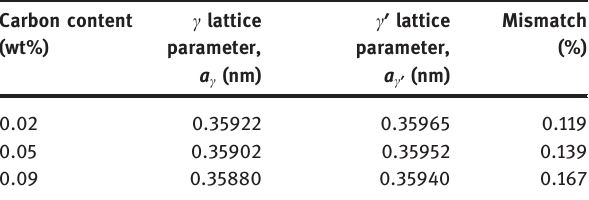
Figure 3: SEM micrograph showing carbides in Incoloy 901 alloys with (a) 0.05 wt% and (b) 0.09 wt% carbon with corresponding SEM-EDS spectra. Table 2: The lattice parameters of γ and γ ′ phases and mismatches between them for Incoloy 901 alloys with (a) 0.02 wt%, (b) 0.05 wt% and (c) 0.09 wt% carbon.